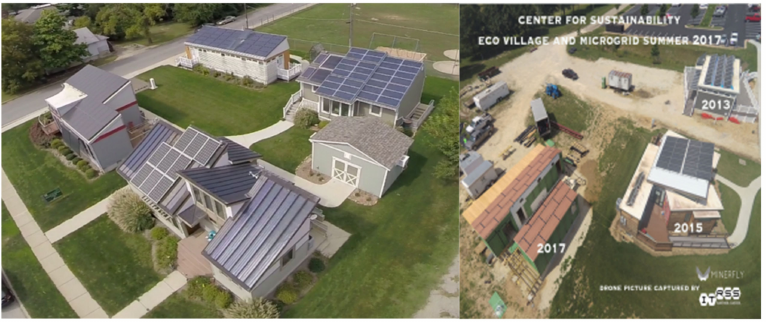
Figure 3. Missouri S&T Solar Microgrid and EcoVillage composed of homes built for the U.S. Solar Decathalon (for a description of the Solar Microgrid located at the Missouri University of Science and Technology, see https://cree.mst.edu/laboratories/, accessed on 20 September